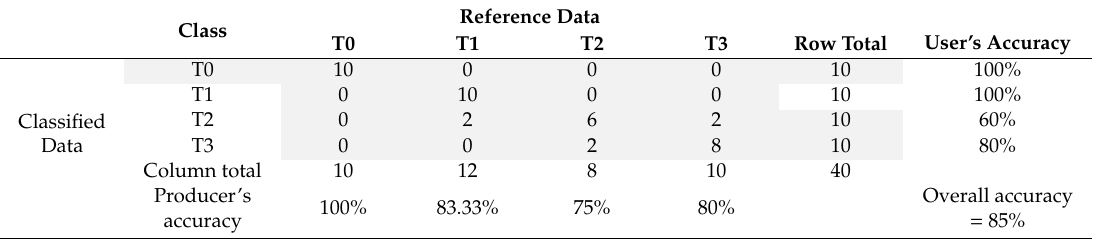
Table 8. Confusion matrix of kernel naïve Bayes (KNB; input of PC1 and PC2).